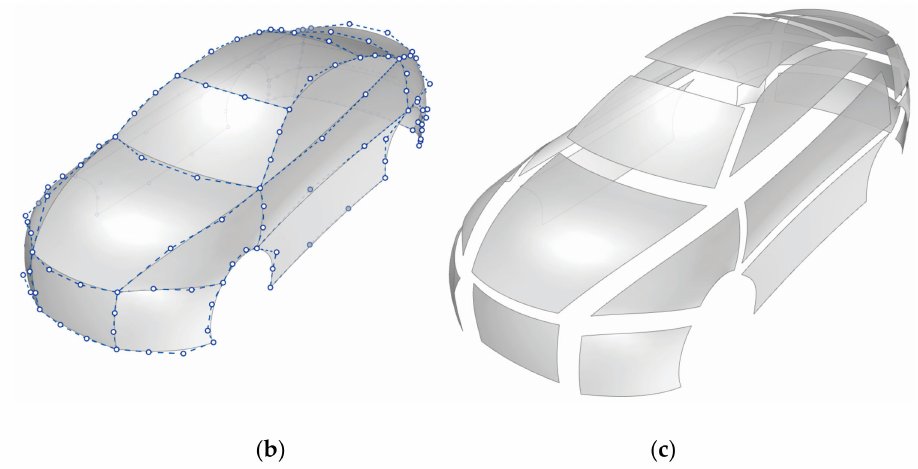
Figure 5. The model template of an automobile proposed in this article: ( a ) Modeling features are extracted from real models; ( b ) 156 control points of boundary curves; ( c ) The template consists of 25 quadrilateral